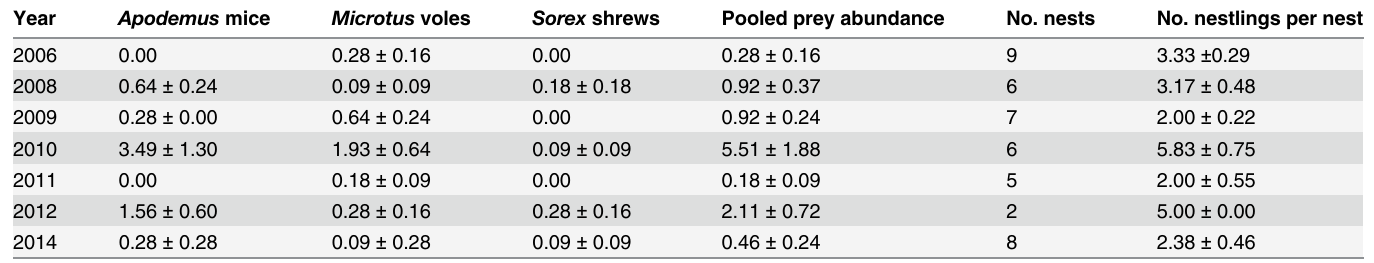
Table 1. Prey abundance index (expressed by number of trapped individuals per 100 trap nights) of separate prey groups, number of nests and number of nestlings measured in each study year. Means (per one hectare trapping area or nest) ± SE are